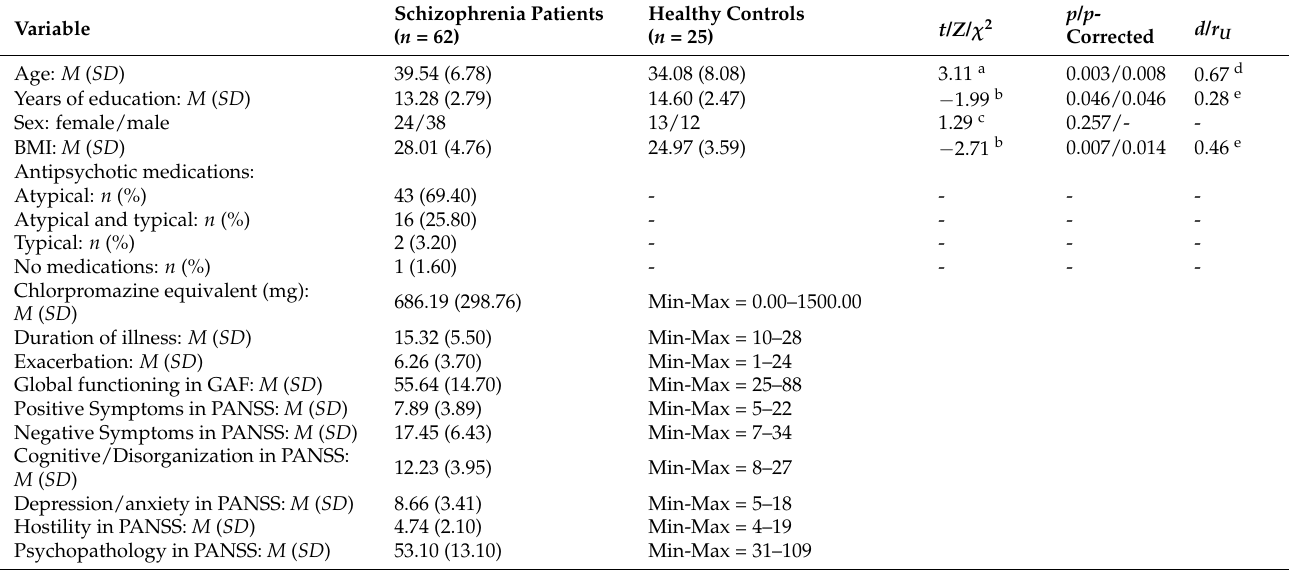
Table 1. Demographic and clinical characteristics and BMI of schizophrenia patients and healthy